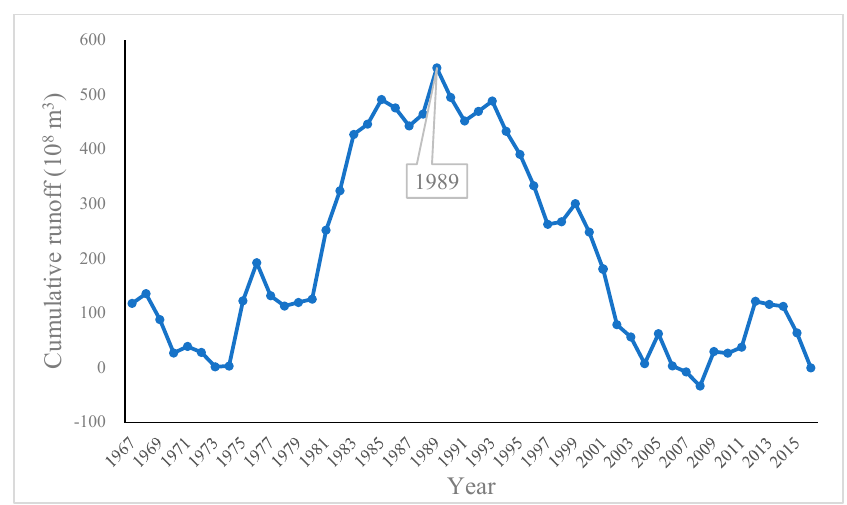
Figure 5. Result of cumulative anomaly mutation analysis in the Tangnaihai station from 1967 ‐ 2016.